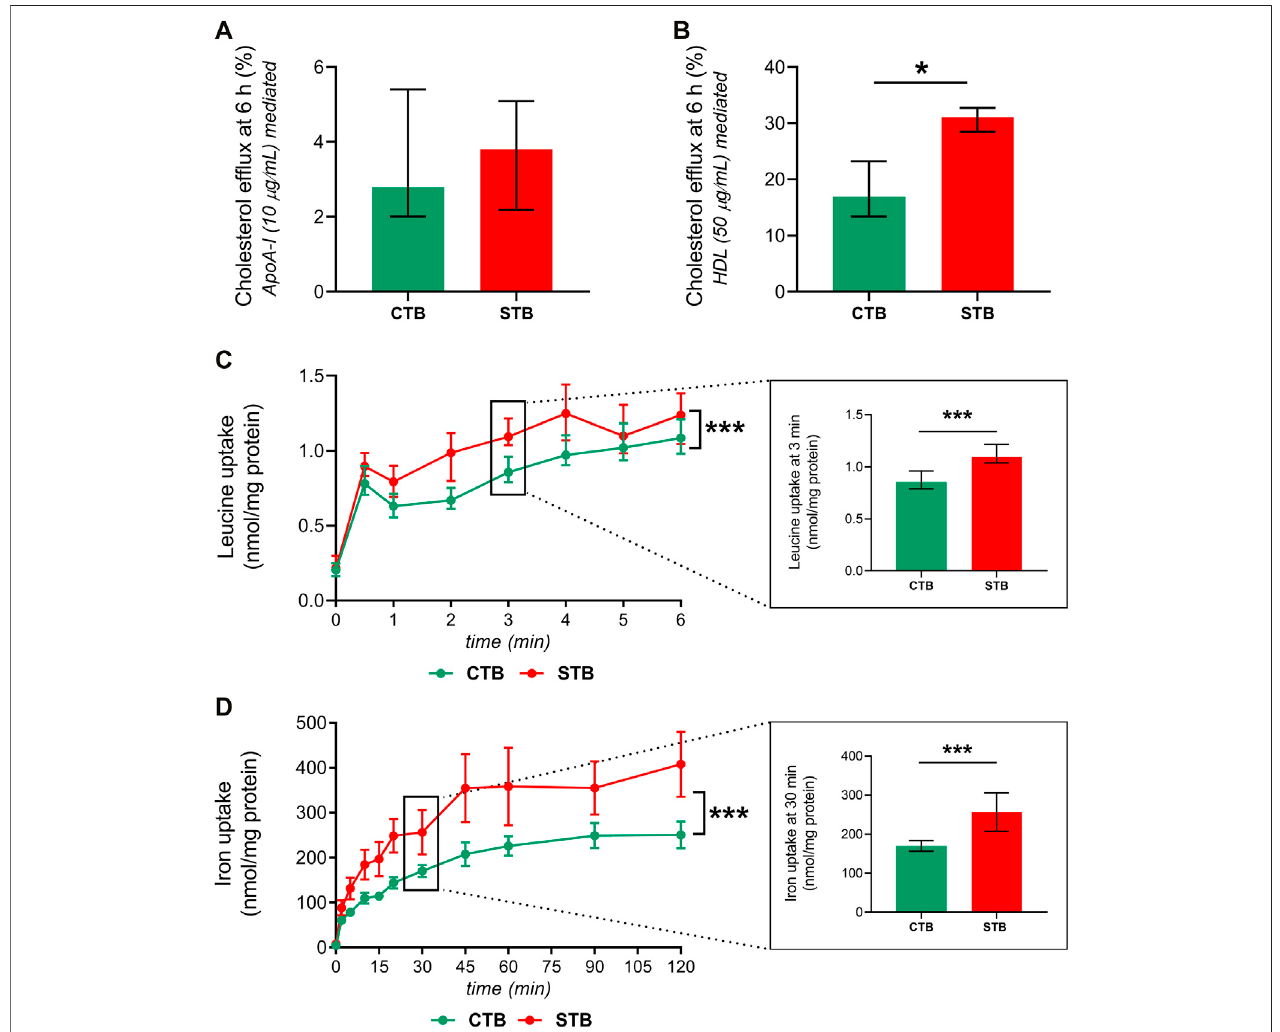
FIGURE 5 | Effect of trophoblast differentiation on the transport of cholesterol, leucine, and iron. CTB, 8 h, and STB, 48 h after seeding, were incubated for 24 h with [ 3 H]-cholesterol (0.5 μ Ci/ml). Subsequently, cholesterol ef fl ux was evaluated in the presence of 10 μ g/ml ApoA-I (A) , ABCA1-mediated) and 50 μ g/ml HDL (B) , ABCG1-mediated)for6 h.Theef fl uxtransporteractivityisshownasthefractionofradioactivesignalinthemedium comparedtothetotalsignalinthemedium andcells. Acceptor-mediated ef fl ux is calculated by subtracting ef fl ux without acceptor from ef fl ux with the acceptor. Leucine (C) , SLC7A5-mediated) and iron (D) , TfR1- mediated)uptakeinCTBandSTBwasassessedinatime-dependentmanner,andtheresultsareshowninnmol/mgprotein.DataarepresentedasmedianwithIQR; n ≥ 3 for each stage. Asterisks indicate signi fi cance according to paired, nonparametric t -test (Wilcoxon test) or two-way ANOVA (for time-dependency studies): * p ≤ 0.05, *** p ≤